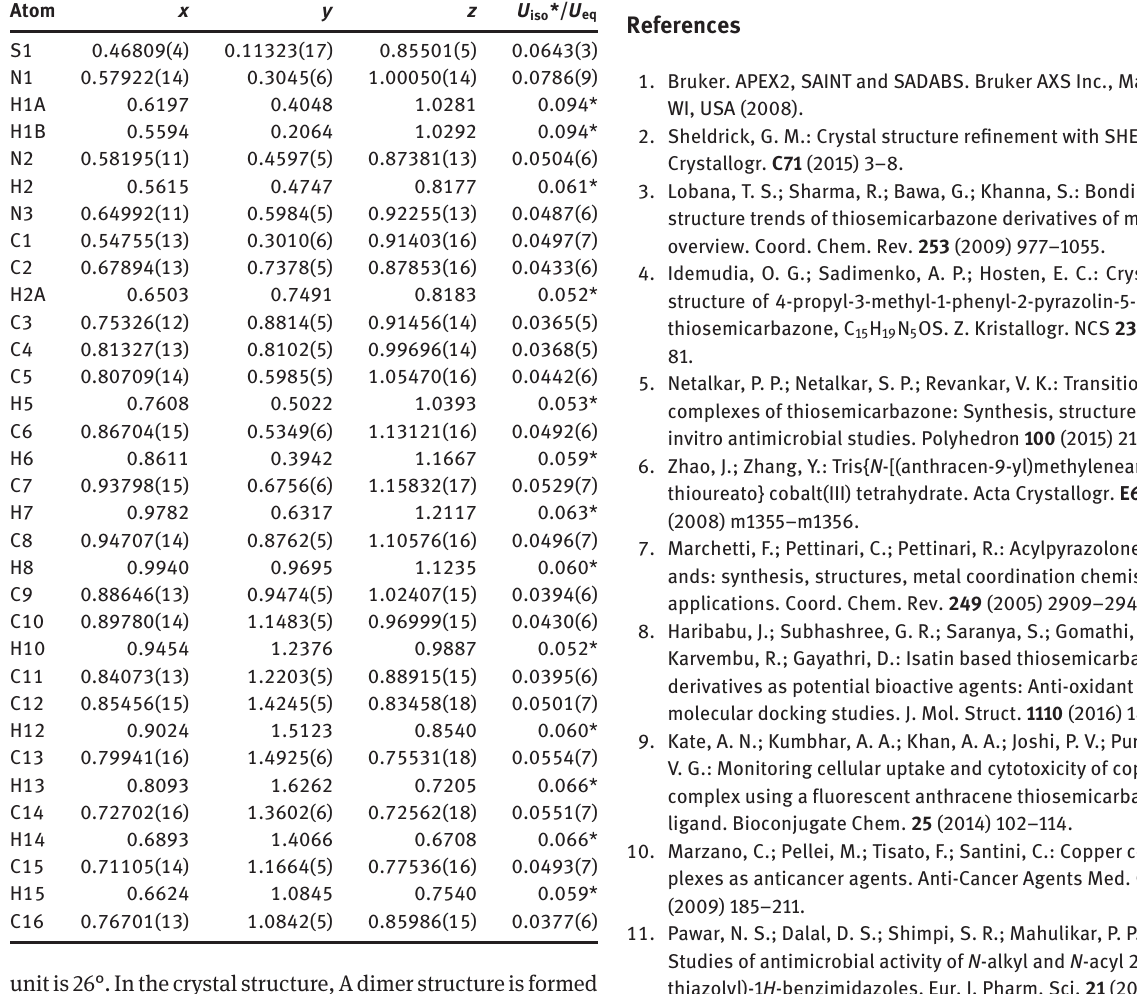
Table 2: Fractional atomic coordinates and isotropic or equivalent isotropic displacement parameters (Å 2